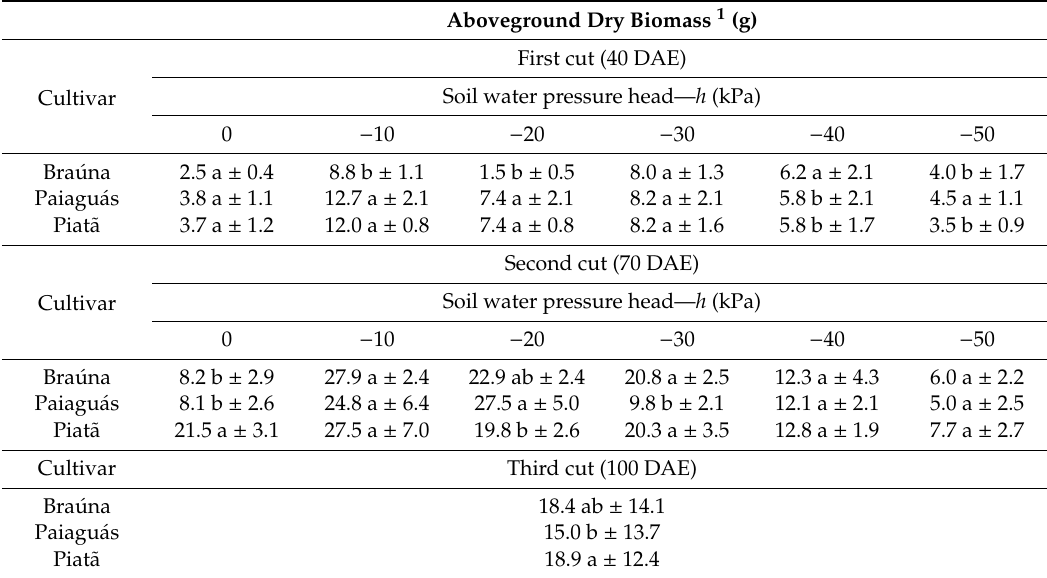
Table 5. E ff ect of soil water pressure head on aboveground dry biomass ( Brachiaria brizantha cultivars) for the three cutting